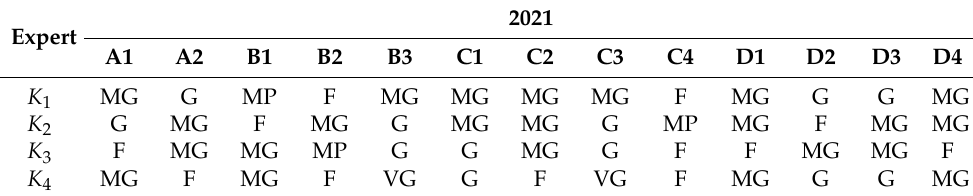
Table 14. Resilience rating scale of Shaanxi Province coal industrial chain and supply chain (2021). Expert